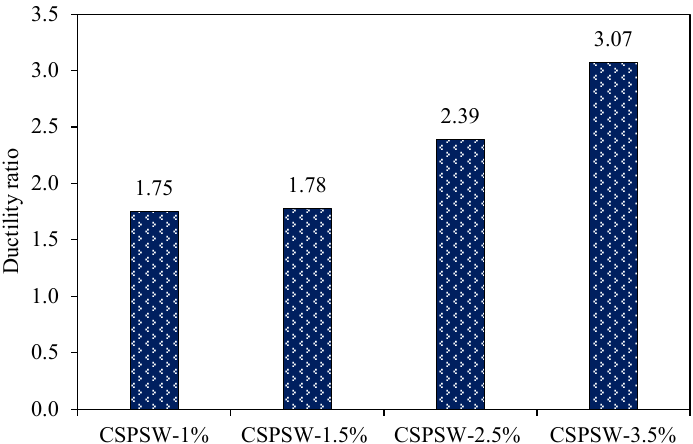
Figure 11. Ductility ratio of group 1.